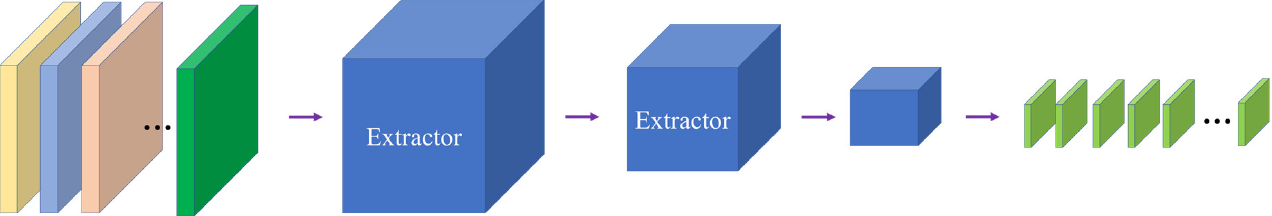
Figure 2. The structure of the Encoder network.